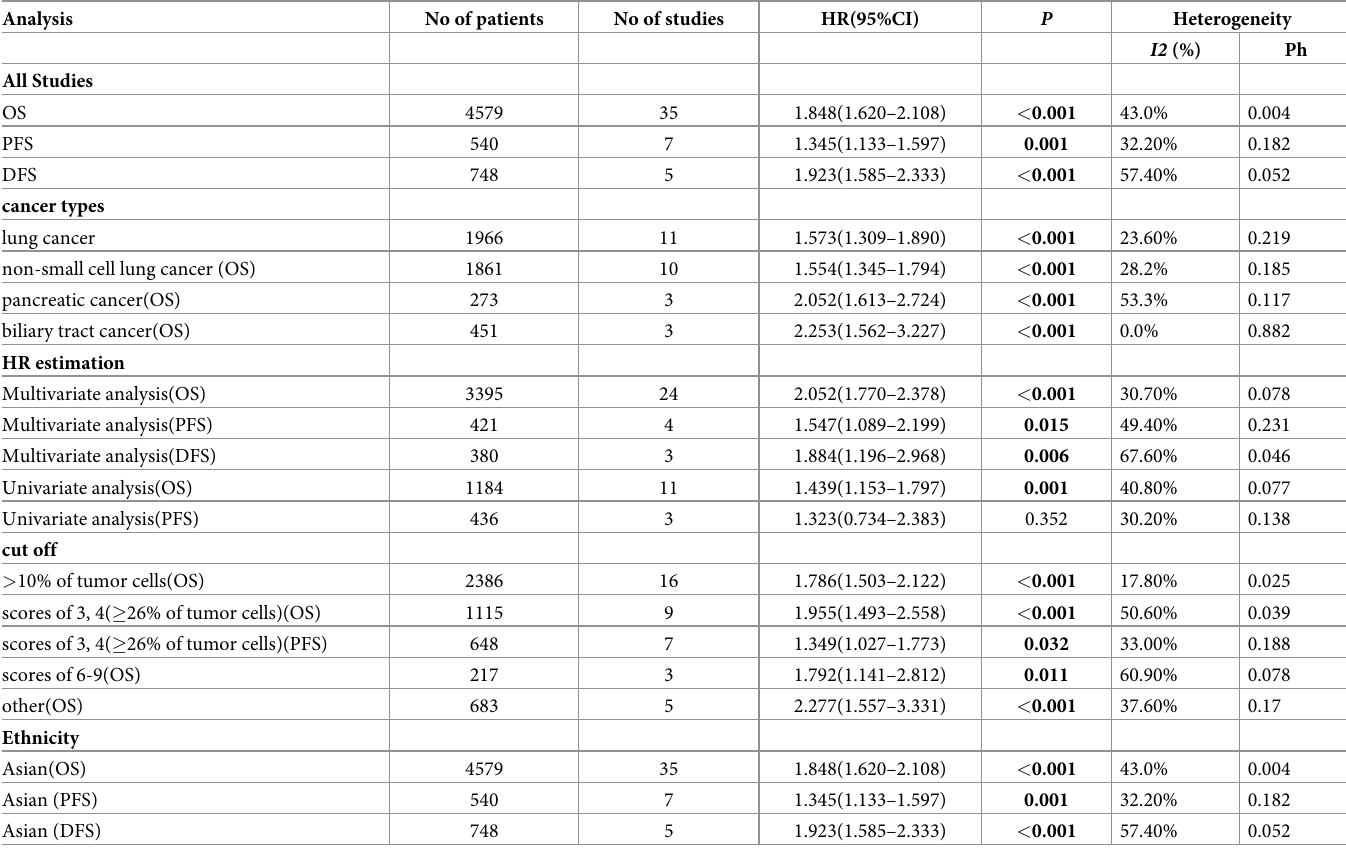
Table 2. Hazard ratio for the association between LAT1 expression and solid tumor